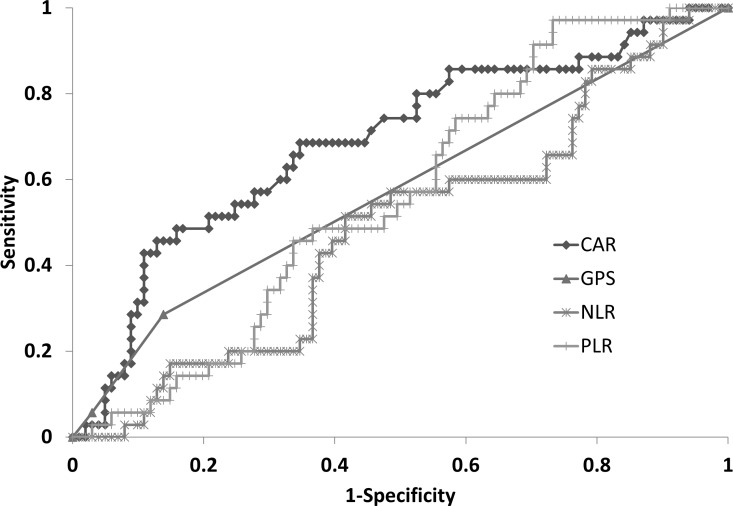
Receiver operating curve analysis for severe side effects.Areas under the curves of the CAR, GPS, PLR, and NLR are 0.79, 0.57, 0.56, and 0.49, respectively. CAR has the highest AUC level among the several inflammation-based scores. CAR, CRP to albumin ratio; NLR, neutrophil to lymphocyte ratio; GPS, Glasgow prognostic score; PLR, platelet to lymphocyte ratio.